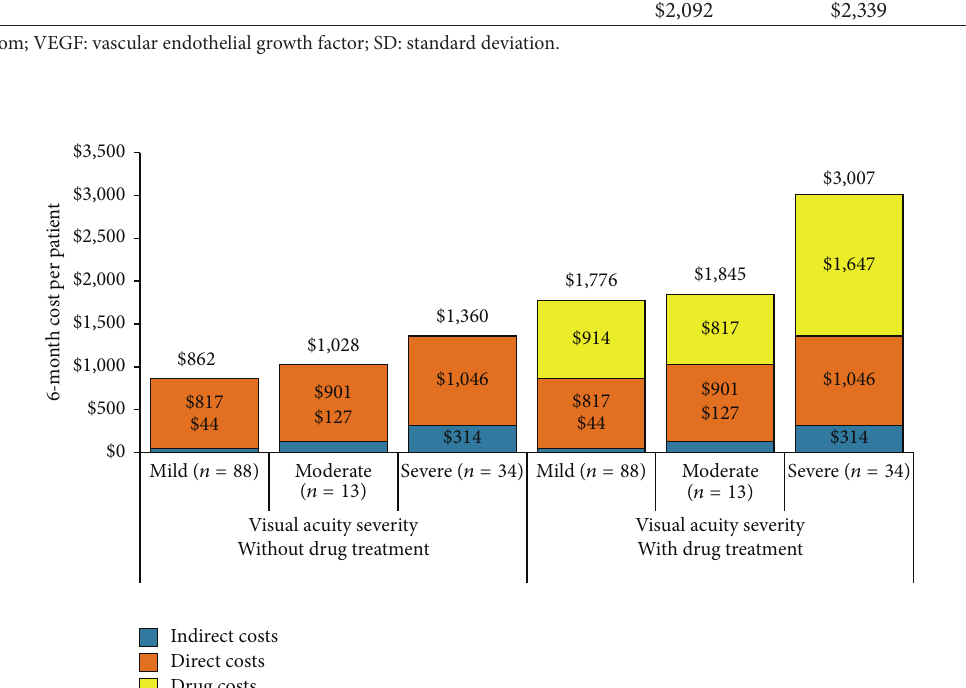
score difference between VA severity levels) was evident for the composite, near and distance activities, social function- ing, mental health, peripheral vision, quality of vision, and vision-related quality of